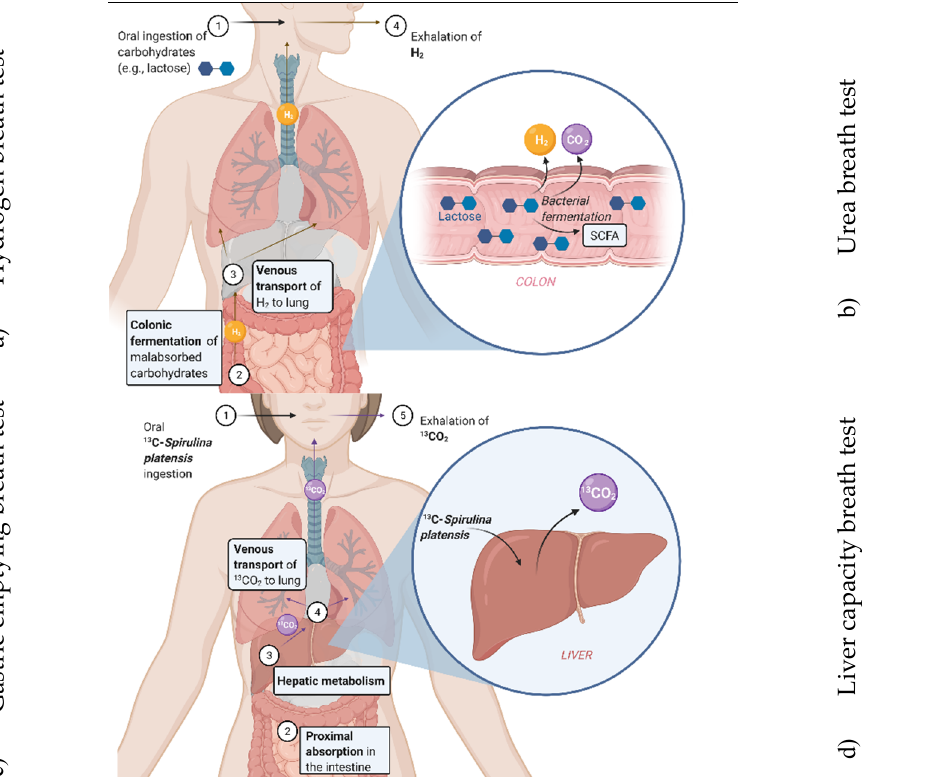
Molecules 2021 , 25 , x; doi: FOR PEER REVIEW www.mdpi.com/journal/molecules